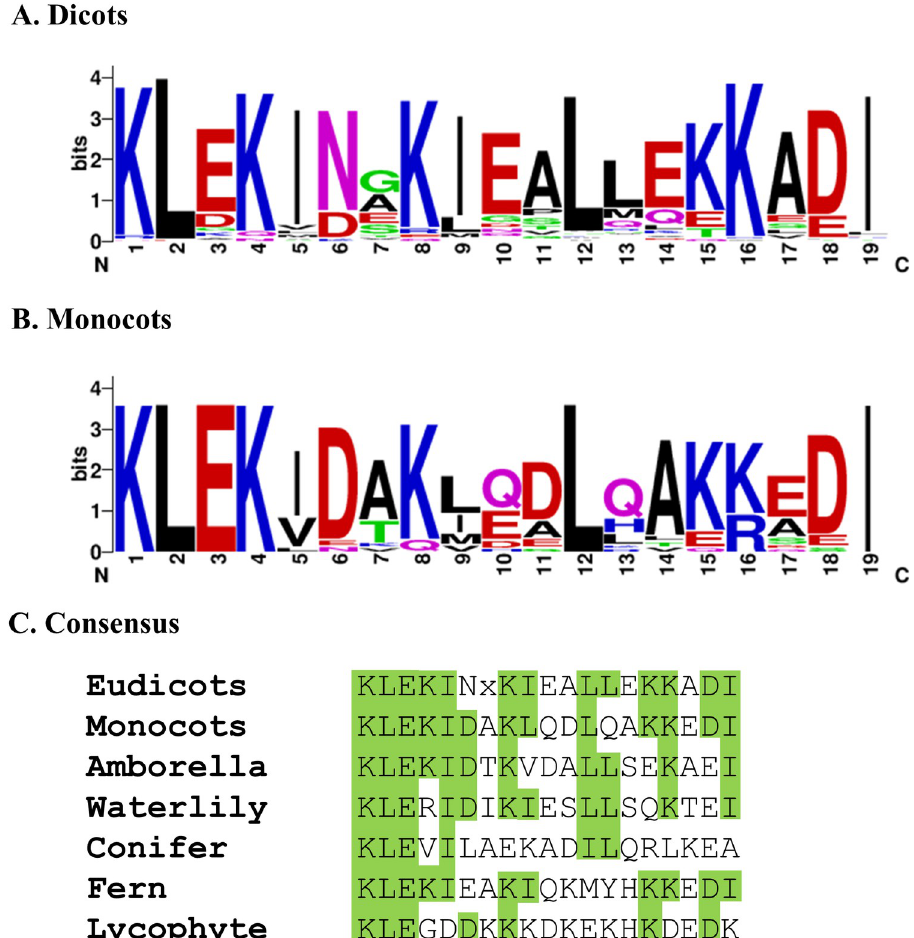
Fig 2. Conserved 19-amino acid domain located near C-terminus of KED proteins in vascular plants (Tracheophyta). Pictograms of the conserved domains are constructed from 68 eudicot species ( A ) and 19 monocot species ( B ). C . The consensus sequences for dicots and monocots are compared to those of basal angiosperms Amborella trichopoda and waterlily Nymphaea spp., a conifer (gymnosperm, Picea glauca ), a fern ( Adiantum capillus- veneris ) and a lycophyte ( Selaginella moellendorffii ). Most conserved residues are shaded in green. L and I are considered synonymous residues in this